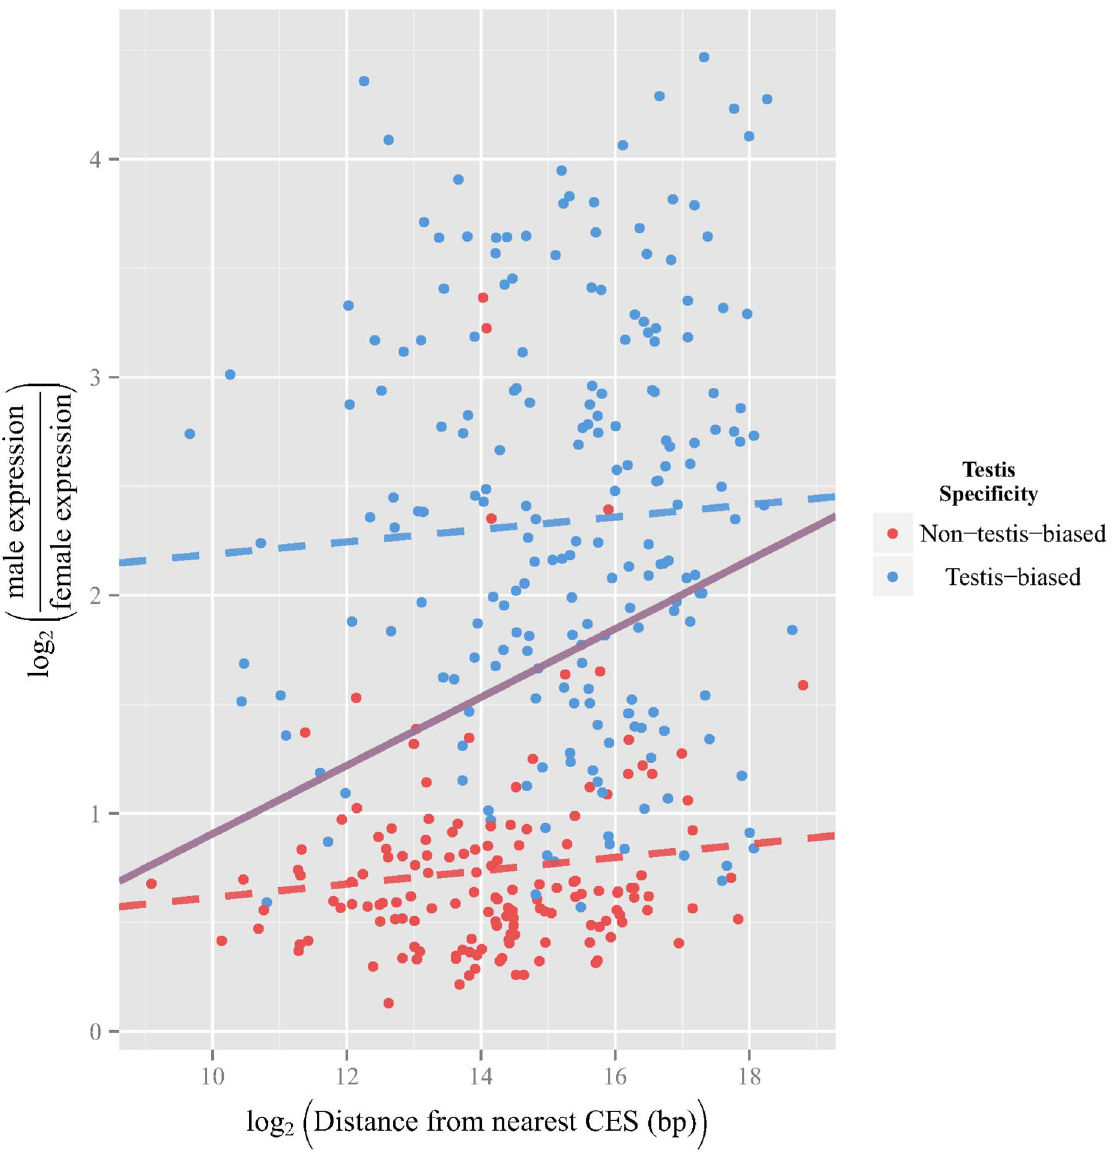
Figure 2. Degree of male expression bias versus distance from nearest chromatin entry site. The degree of male expression (as measured male exp : ) for each gene is plotted against the logarithmic distance to its nearest chromatin entry site. We recapitulate the previous by log 2 female exp : observation of a significant positive correlation (purple line, r ~ 0 : 29, p v 0 : 001 ); however, after partitioning X -linked MBGs into testis-biased and non- testis-biased the relationship between male-bias magnitude and distance from the nearest CES becomes non-significnat for non-testis-biased X - linked MBGs (red dashed line, r ~ 0 : 08, p § 0 : 05 ) and testis-biased genes (blue dashed line, r ~ 0 : 04, p § 0 : 05 ).